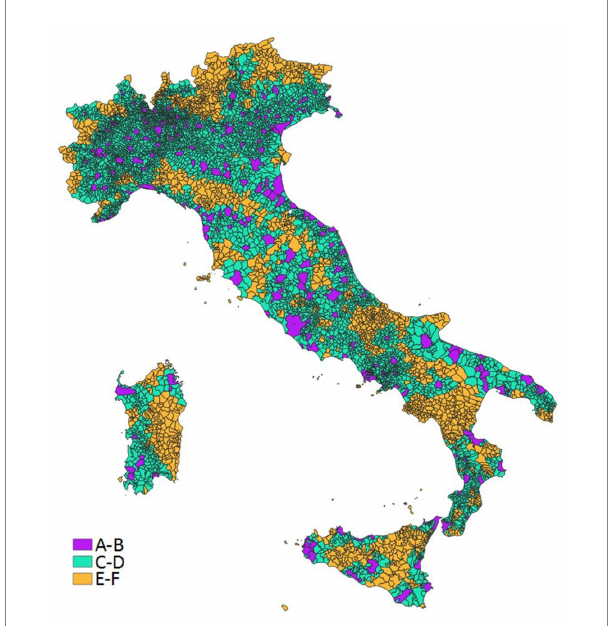
FIGURE 1 Distribution of the municipalities in metropolitan (A-B), peri-urban/ intermediate (C-D) and inner (E-F)